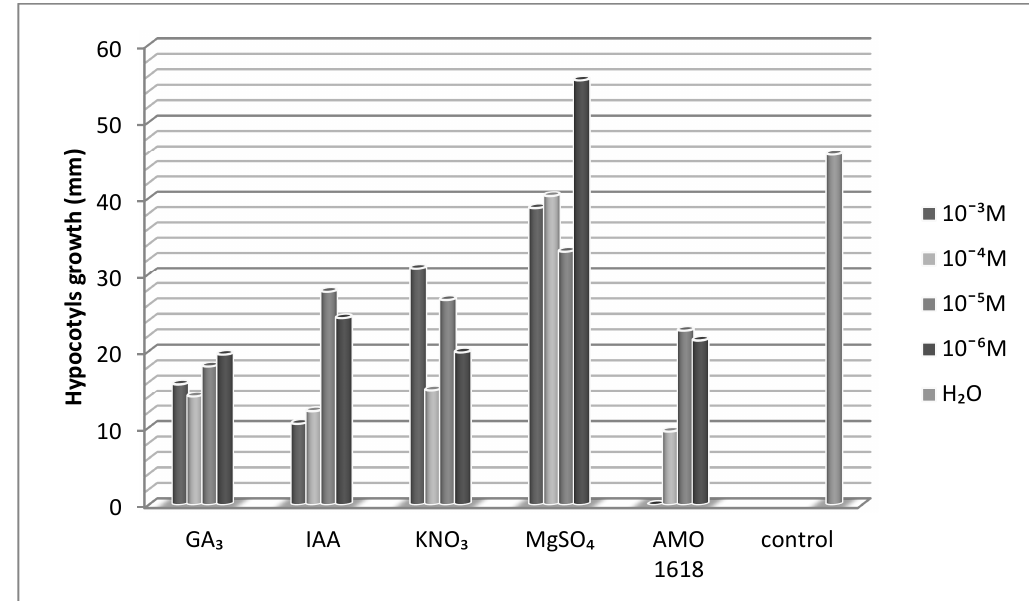
Figure 4. Triticale hypocotyls growth under the influence of plant growth regulators and inhibitor AMO